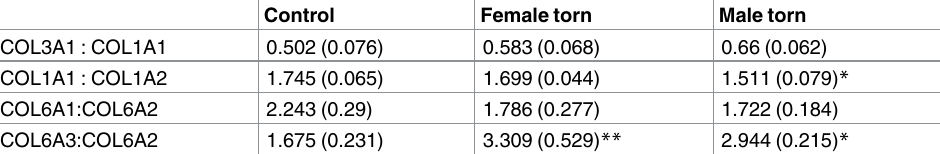
Table 4. The ratios of COL3A1 to COL1A1, and of the subunits of Collagen I and Collagen VI in the three groups, Mean(SEM), * P < 0.05 ** P < 0.01significantly different from control. Control Female